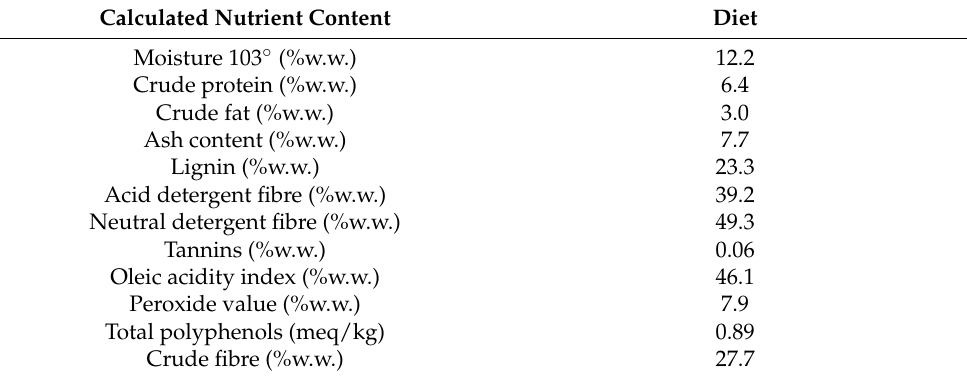
Table 2. Fermented defatted “alperujo” nutrient composition.